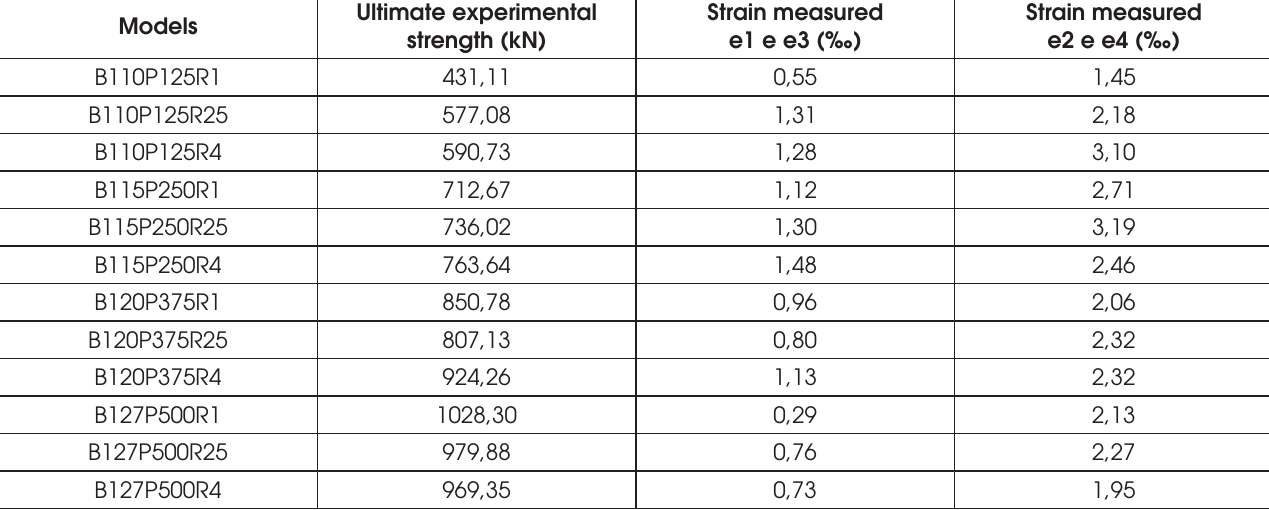
Strain measured by strain gages x ultimate experimental strength